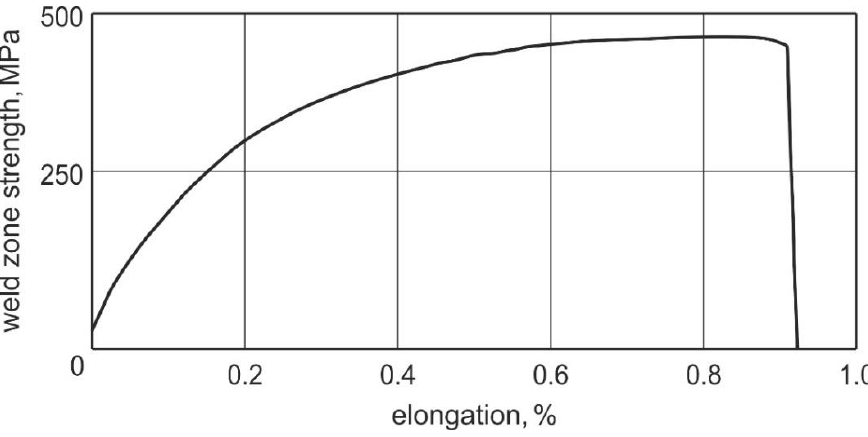
Figure 8. The stress – strain diagram of the welded zone of the